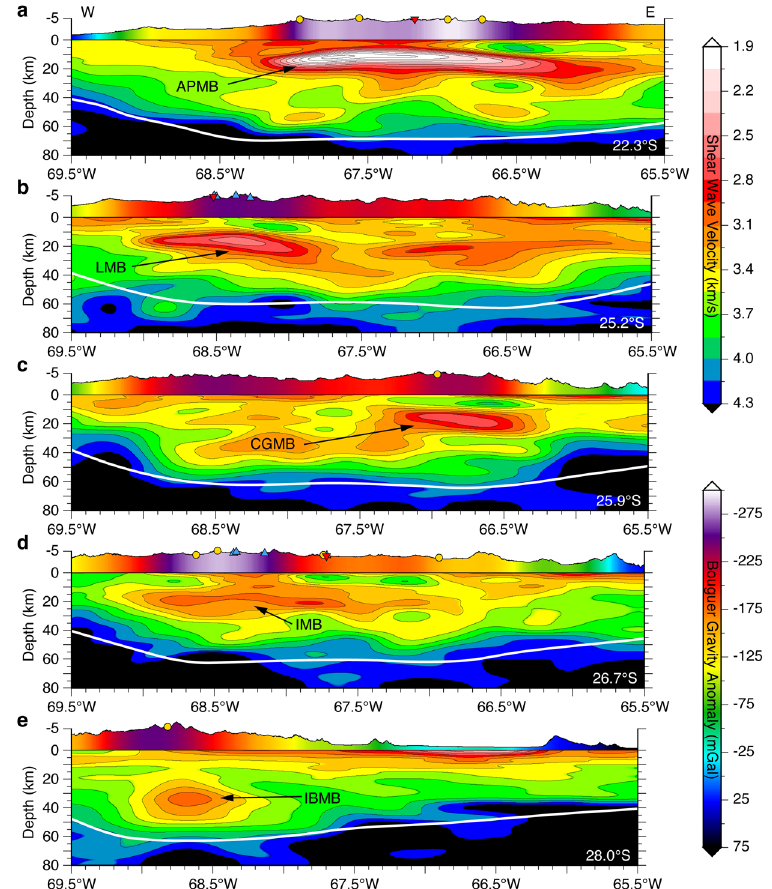
Figure 2. ( a–e ) West-east cross-sections through our shear-wave velocity model with the locations shown in the lower right corner. Blue triangles show Holocene age volcanism of the Central Volcanic Zone (CVZ), gold circles show known ignimbrite eruption calderas, inverted red triangles show INSAR measured vertical surface deformation centers, and white lines are the Moho 28, 62 . Vertically exaggerated (3:1) unfiltered topography is colored by the magnitude of the Bouguer gravity anomaly at that location 60 . The labels APMB (Altiplano-Puna Magma Body), LMB (Lazufre Magma Body), CGMB (Cerro Galan Magma Body), IMB (Incahuasi Magma Body), and IBMB (Incapillo-Bonete Magma Body) correspond to imaged magma reservoirs discussed in the text. These plots were made using the Generic Mapping Tool 61 , version 4.5.1